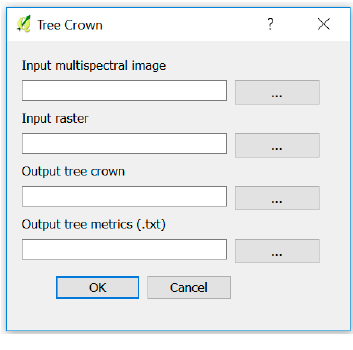
Figure 2. Plugin graphic interface.